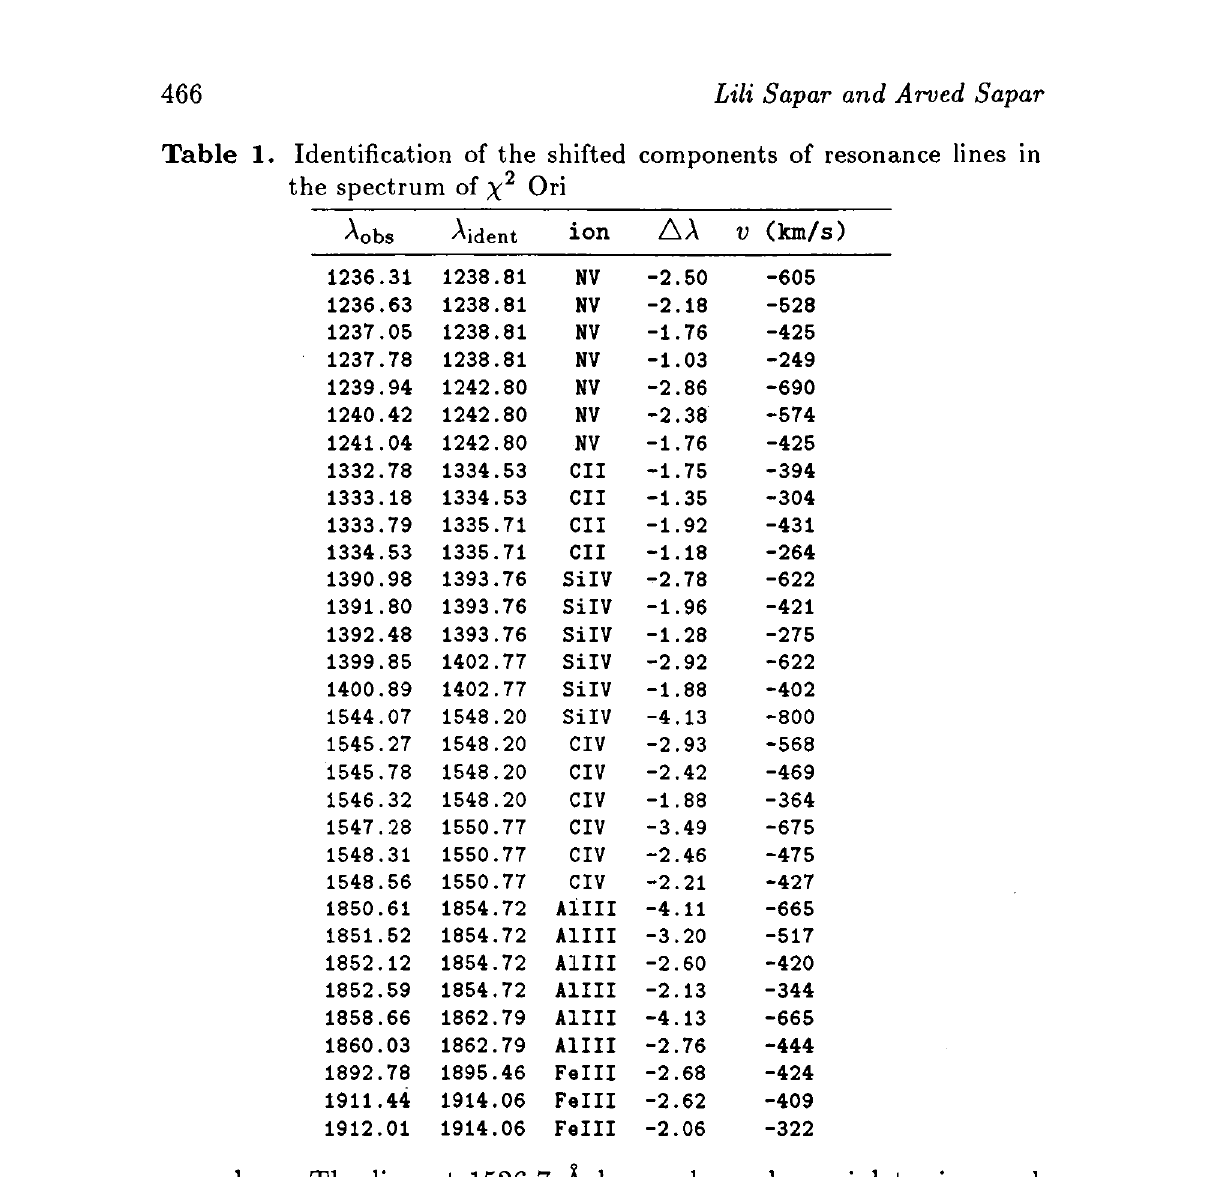
Table 1. Identification of the shifted components of resonance lines in the spectrum of x 2